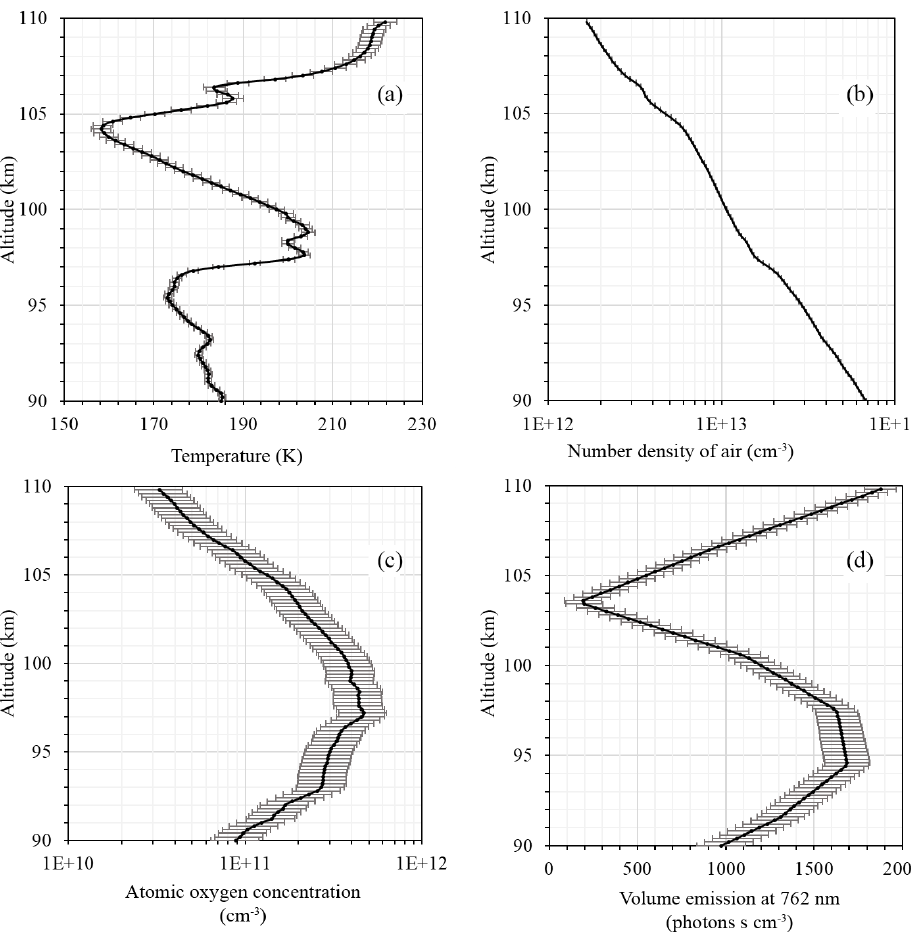
Figure 1. Measurements of (a) temperature (CONE), (b) number density of air (CONE), (c) atomic oxygen concentration (FIPEX), and (d) volume emission at 762nm